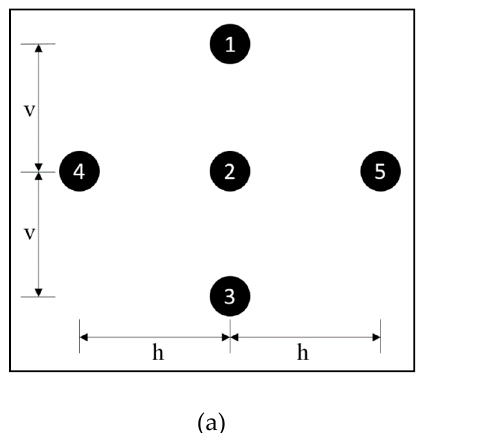
Figure 5. General arrangement of vibration motors for spacing study: ( a ) theoretical arrangement of vibration motors; ( b ) vibration motors embedded on waist belt.